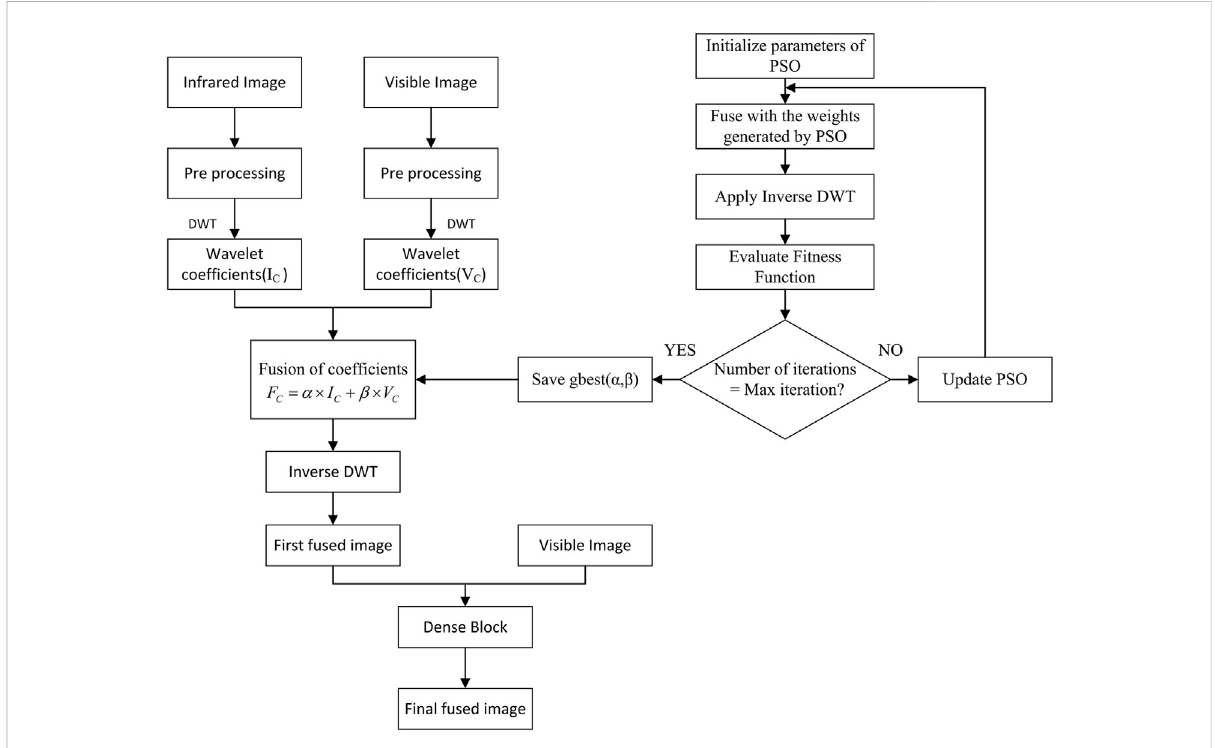
FIGURE 1 The framework of proposed image fusion